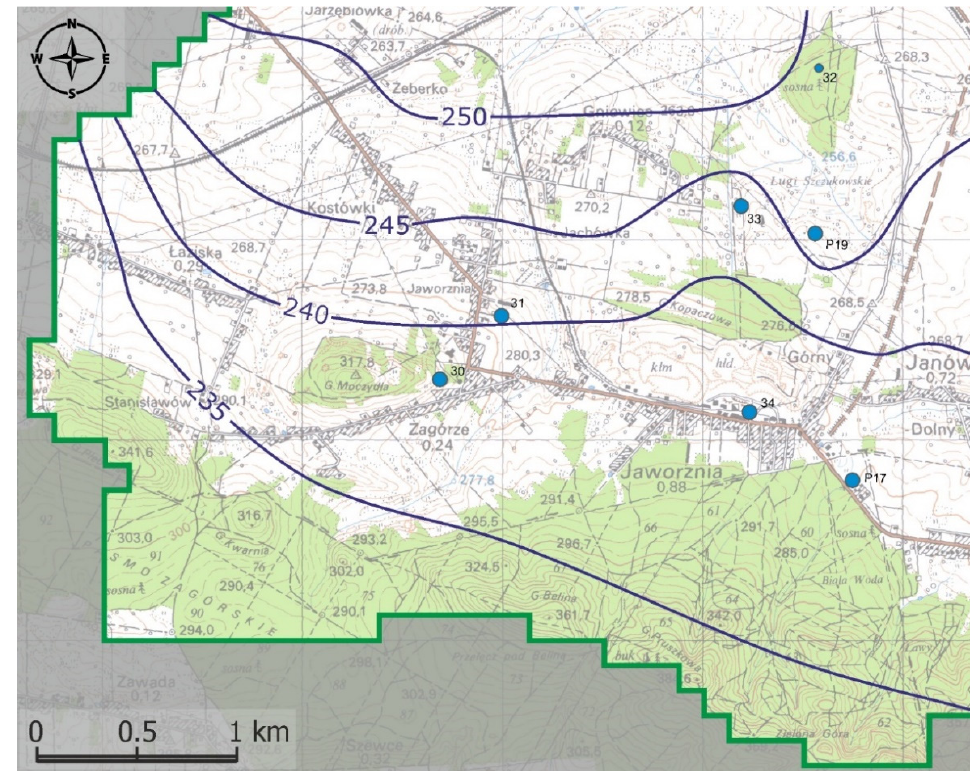
Figure 3. Hydrodynamic field layout (blue lines—groundwater table contours in m a.s.l.) with observation wells (light blue circles) in the SW part of the studied area. The state observed in 2017.